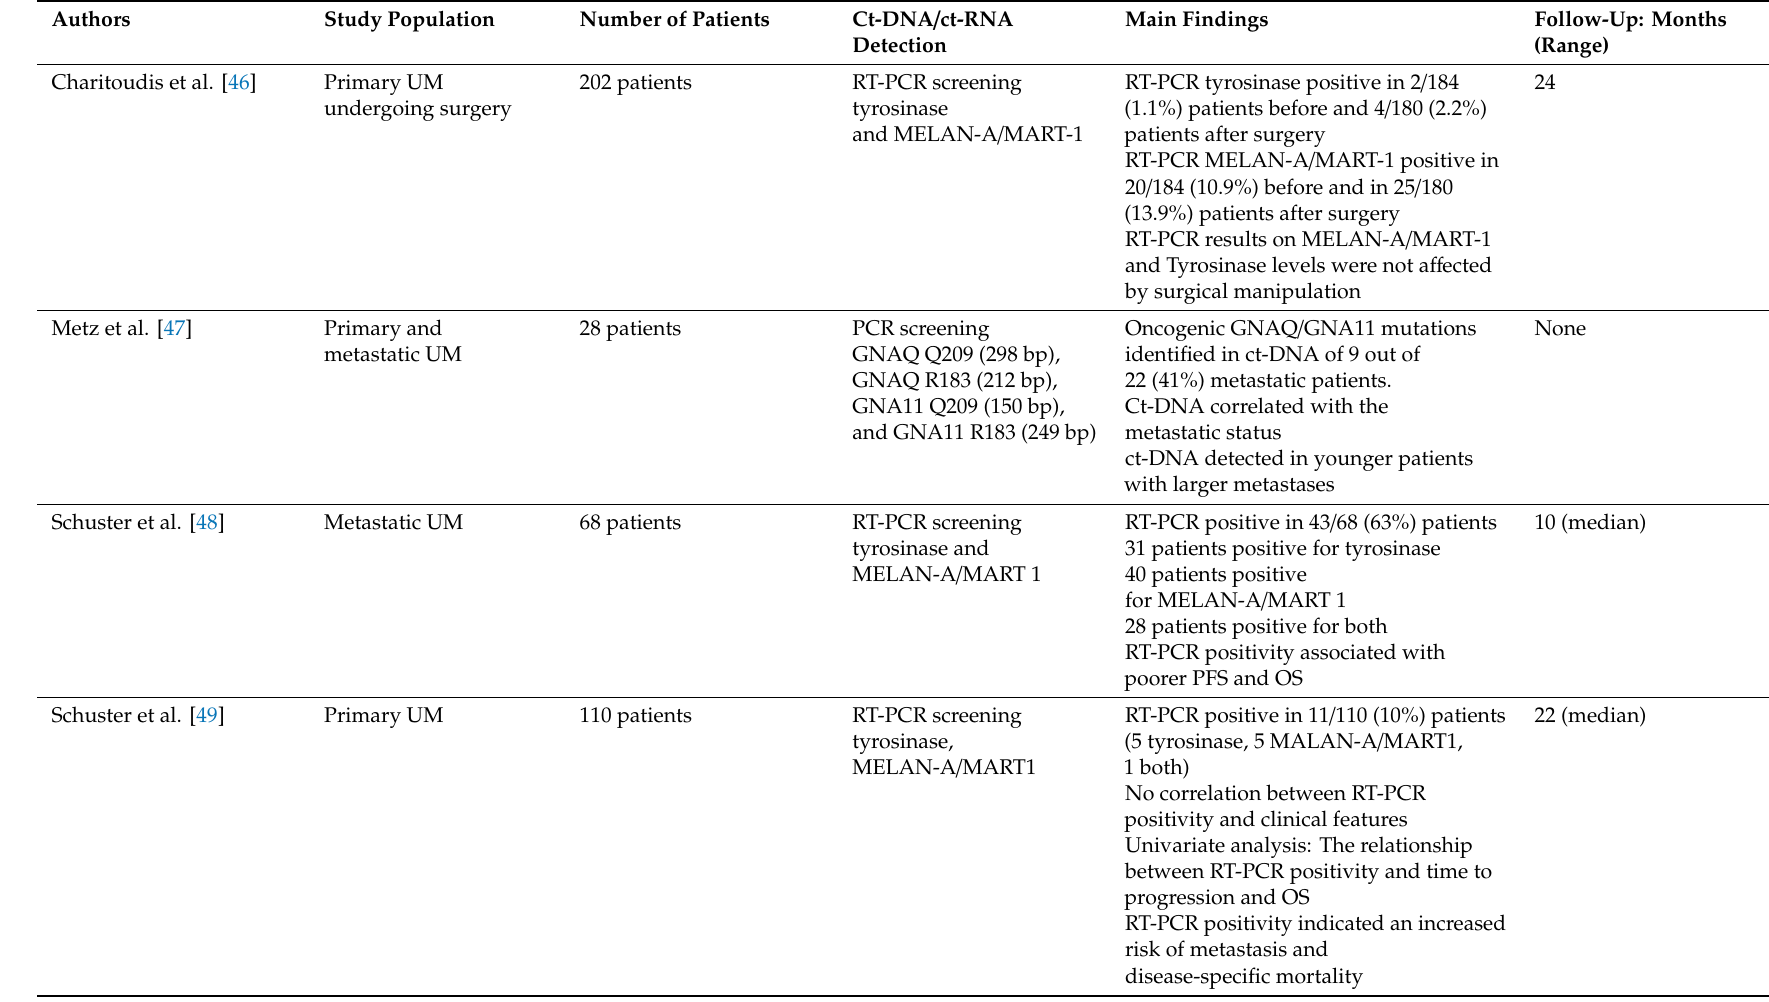
Table 3. Summary of the main studies investigating ct-DNA and ct-RNA in uveal